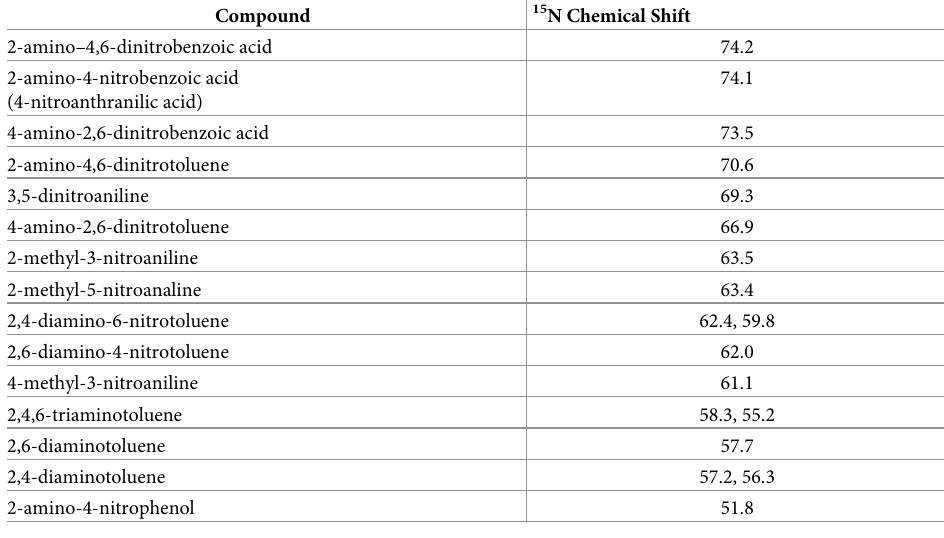
Table 4. N-15 NMR chemical shifts of aromatic amine nitrogens a .